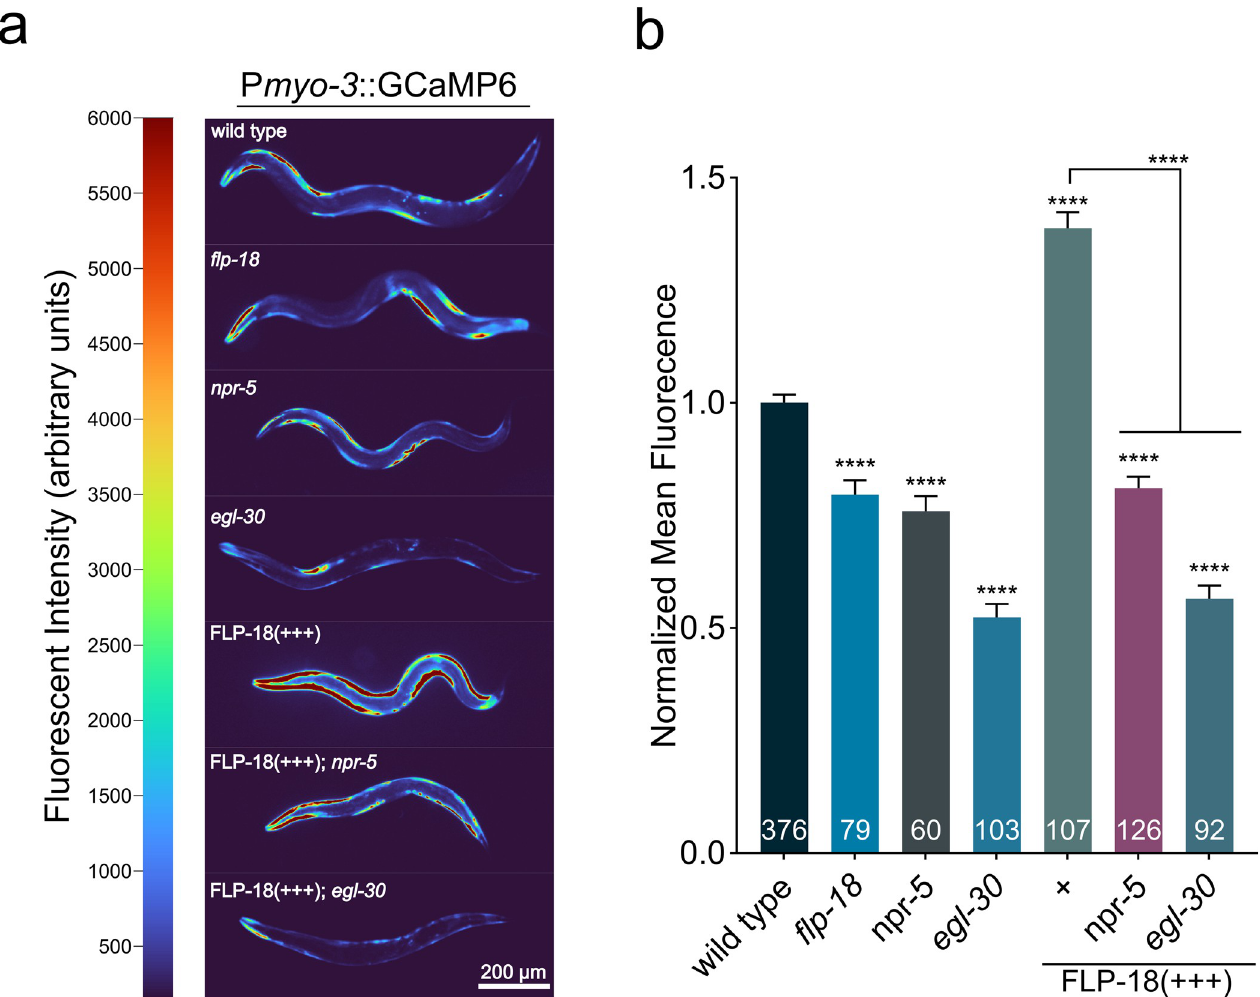
animals expressing a P myo-3 ::GCaMP6 transgene in different genetic backgrounds. Grayscale images have been recolored for visibility. Pixel intensity values (arbitrary units) and corresponding colormap are depicted in the color bar to the left of images. Scale bar represents 200 μ m. (B) Quantification of mean GCaMP6 fluorescence in body wall muscle in different genetic backgrounds. Graphs represent mean ± SEM, significance was calculated using ANOVA with S ˇ ida ´ k’s multiple comparison correction (P < 0.0001 = ���� ). Sample size for each genotype is indicated at the base of each